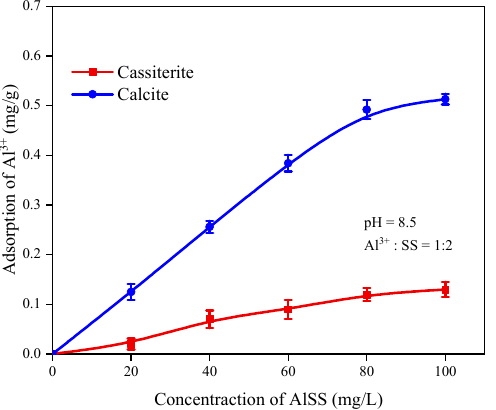
Figure 10. Amount of Al 3+ adsorbed on the surface of minerals as a function of AlSS concentration.